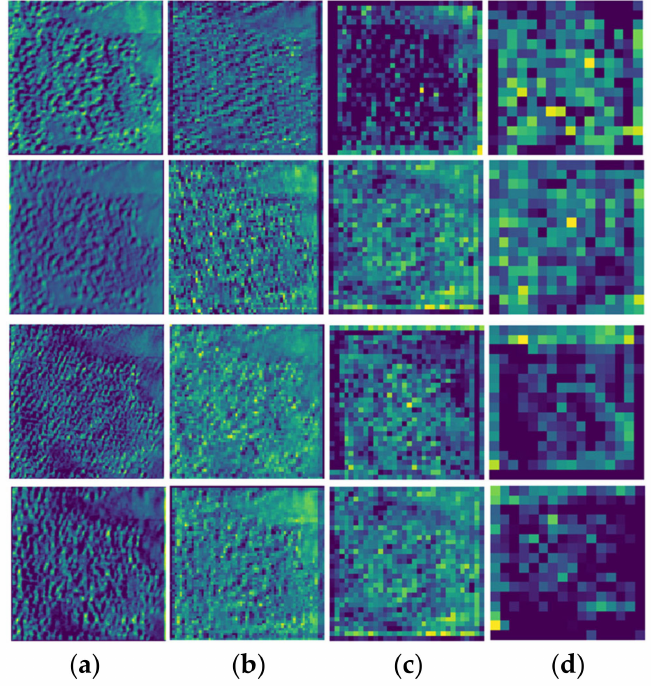
Figure 14. The visualization of the four resolution stage’s feature maps in encoding part of the model proposed in Figure 8: ( a ) input of the first max pooling layer; ( b ) input of the second max pooling layer; ( c ) input of the third max pooling layer; ( d ) input of the fourth max pooling layer. Each column represents a randomly selected kernel within the corresponding max pooling layer.